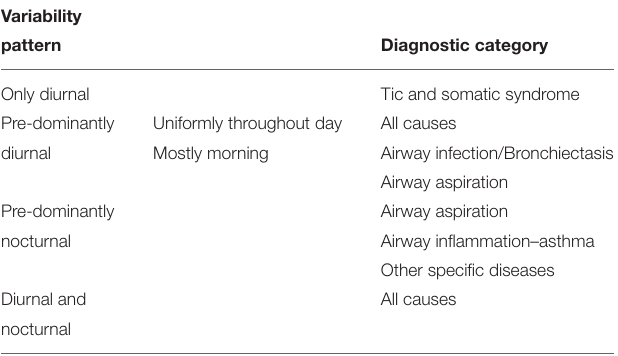
TABLE 9 | Variability during the day and potential diagnostic category.